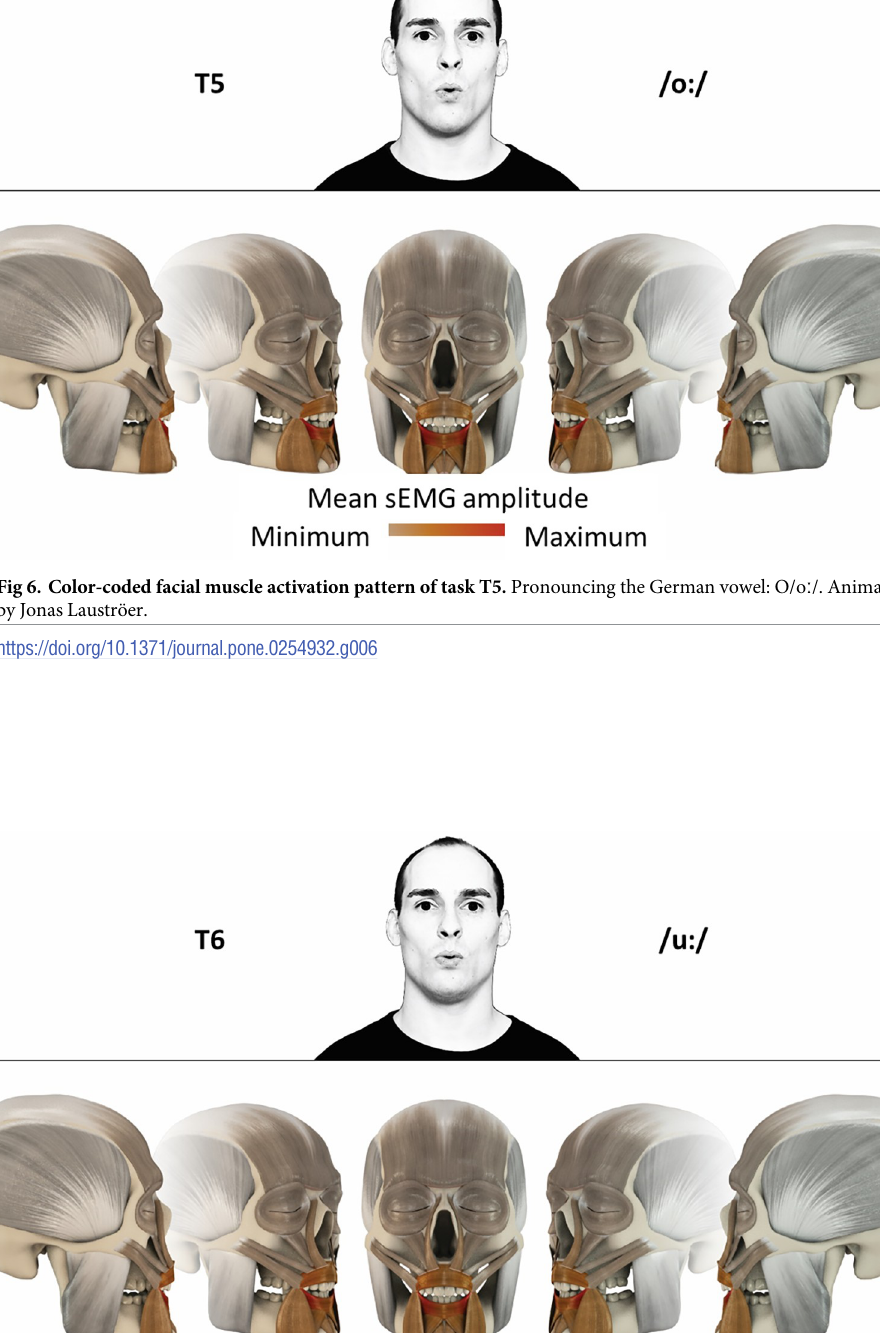
PLOS ONE | https://doi.org/10.1371/journal.pone.0254932 July 19,